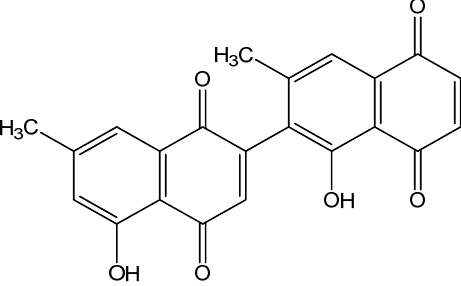
Figure 1. Chemical structure of diospyrin.